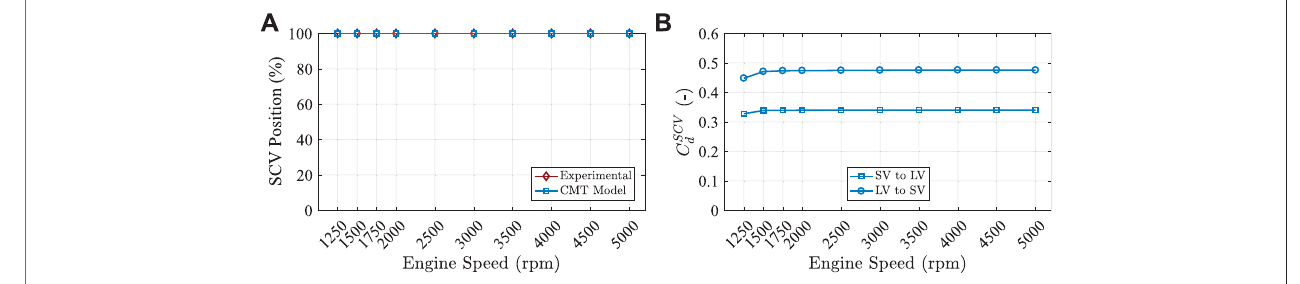
FIGURE 12 | CMT-DETCM model SCV positions and the estimated discharge coef fi cient values at different engine speeds.